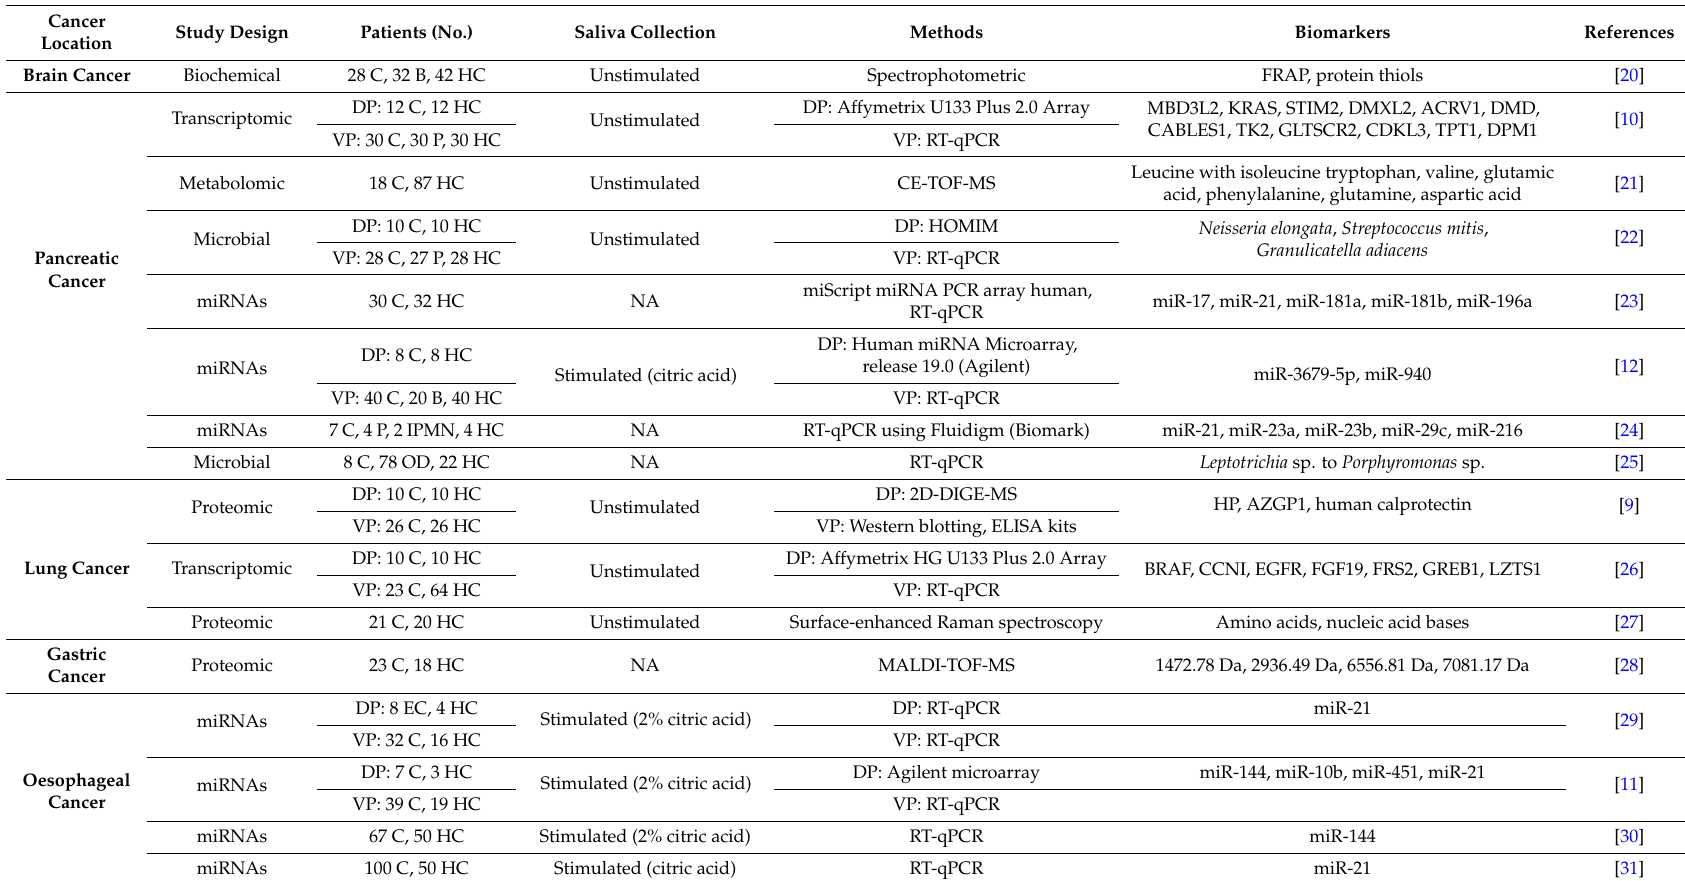
Table 1. Studies of saliva-based